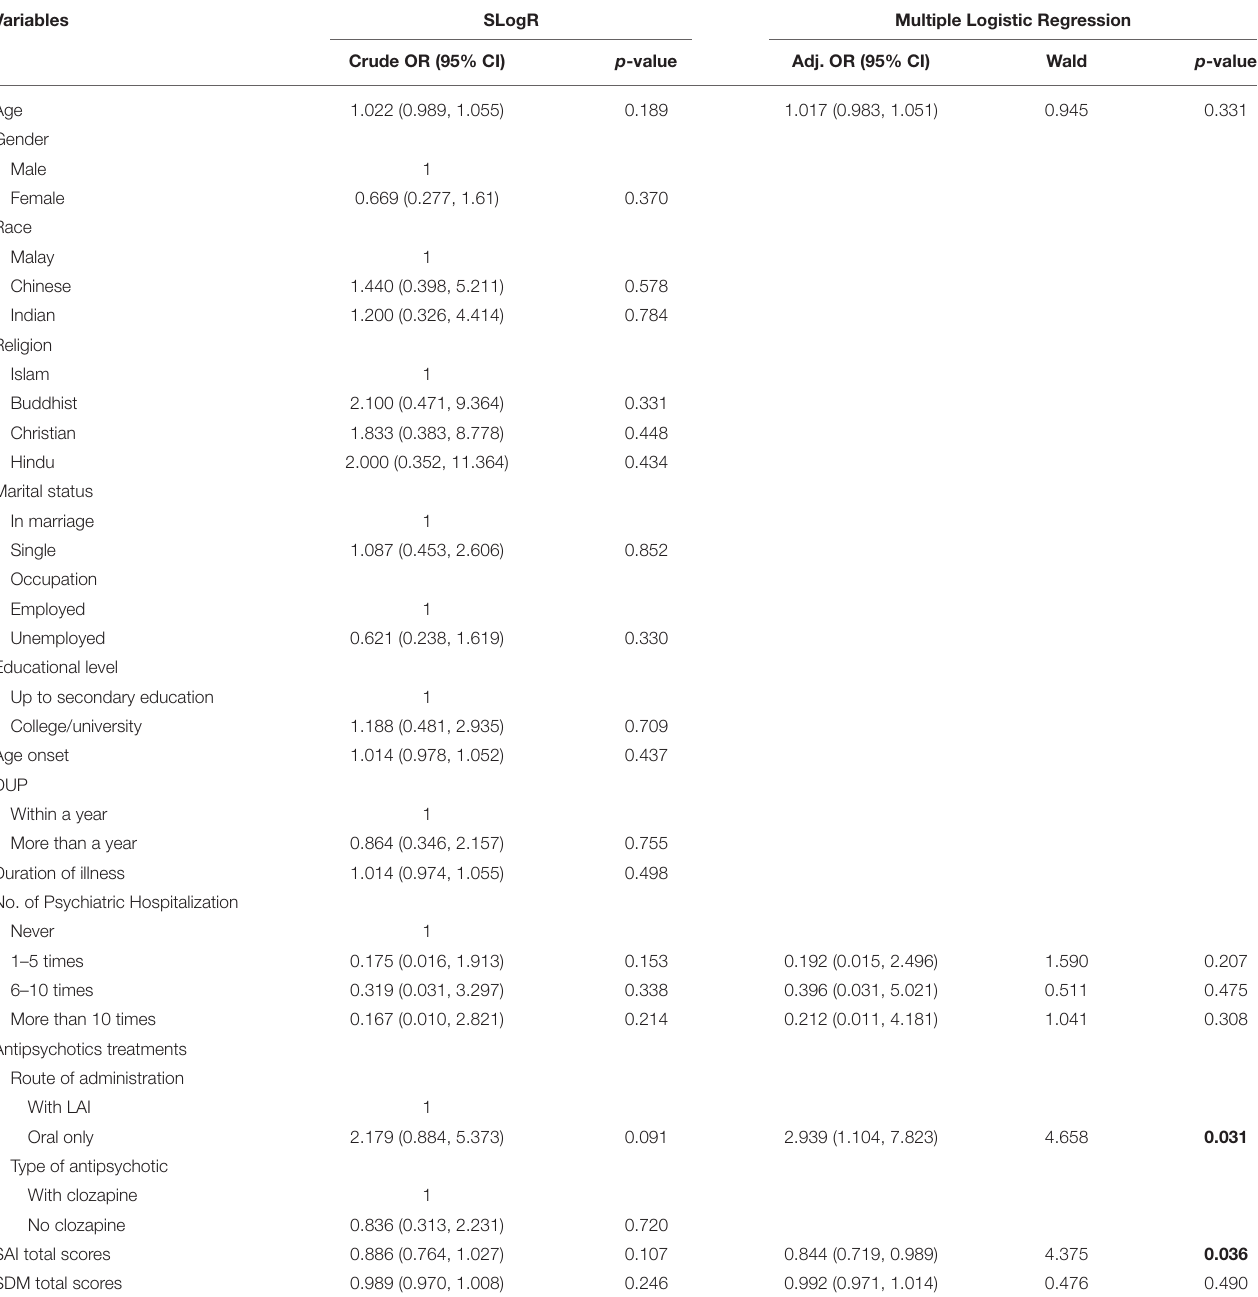
TABLE 4 | Factors associated with role preference using SLogR and multiple logistic regression.